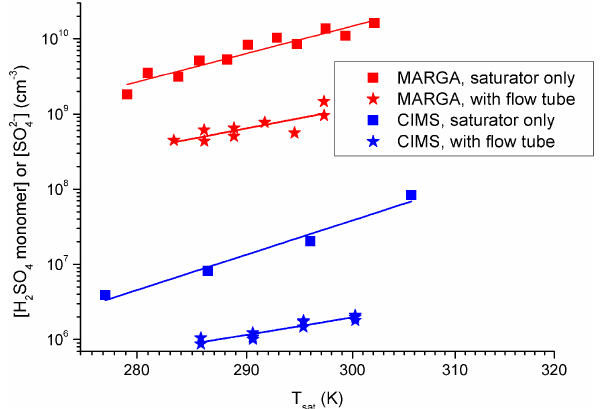
Figure 4. Comparison of MARGA and CIMS data between test with saturator only (dry conditions, squares) and with saturator and flow tube (RH ∼ 30%, stars). Different flow rates through saturator have been accounted for. Average total loss factors are TLF MARGA = 10.0 ± 1.2 and TLF CIMS = 14.2 ± 4.2. See text for